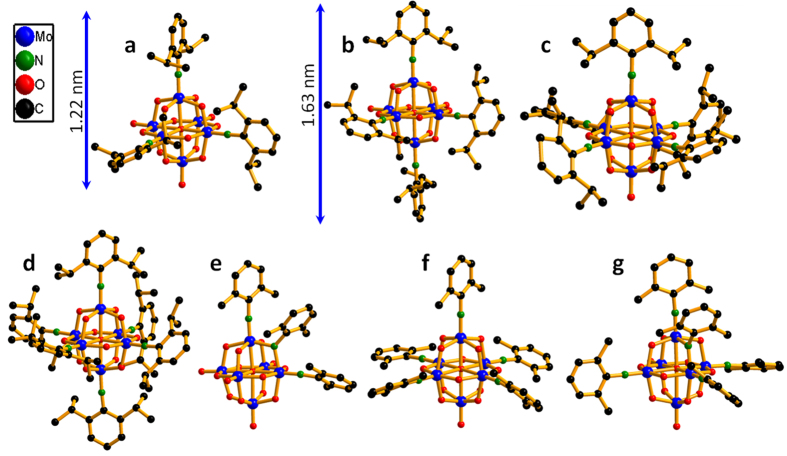
The ball and stick structures and sizes of some important polysubstituted derivatives of hexamolybdates.(a) [Mo6O16(NAr)3]2− (3-Ar); (b) [Mo6O15(NAr)4]2− (4-Ar); (c) [Mo6O14(NAr)5]2− (5-Ar); (d) [Mo6O13(NAr)6]2− (6-Ar); (e) [Mo6O16(NAr′)2(μ2-NAr′)]2− (3-Ar-III); (f) [Mo6O14(NAr′)5]2− (5-Ar-I); (g) [Mo6O14(NAr′)4(μ2-NAr′)]2 (5-Ar-II)1920212234.